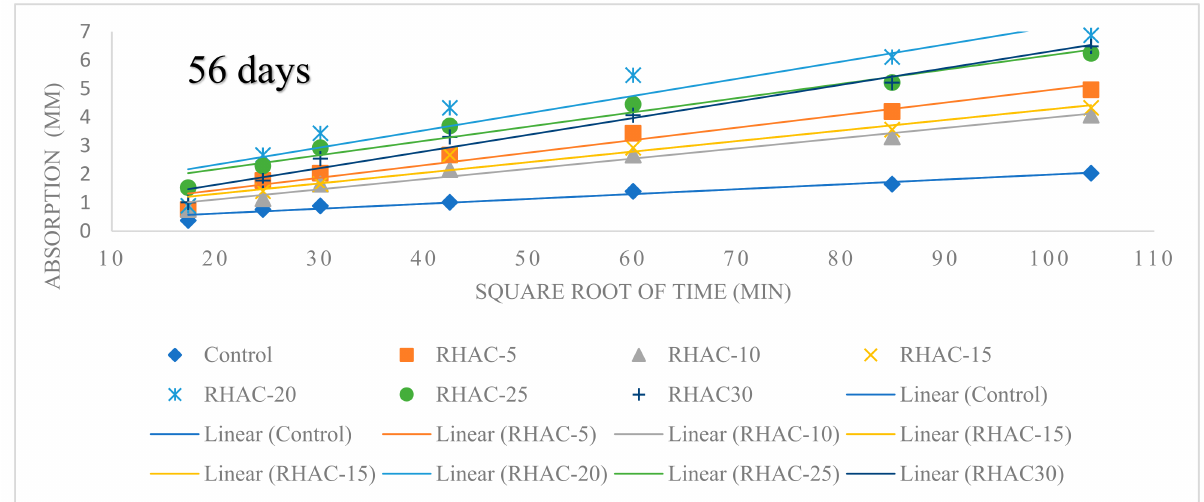
Figure 12. Sorptivity characteristics of HPCs with RHA for 56 days.